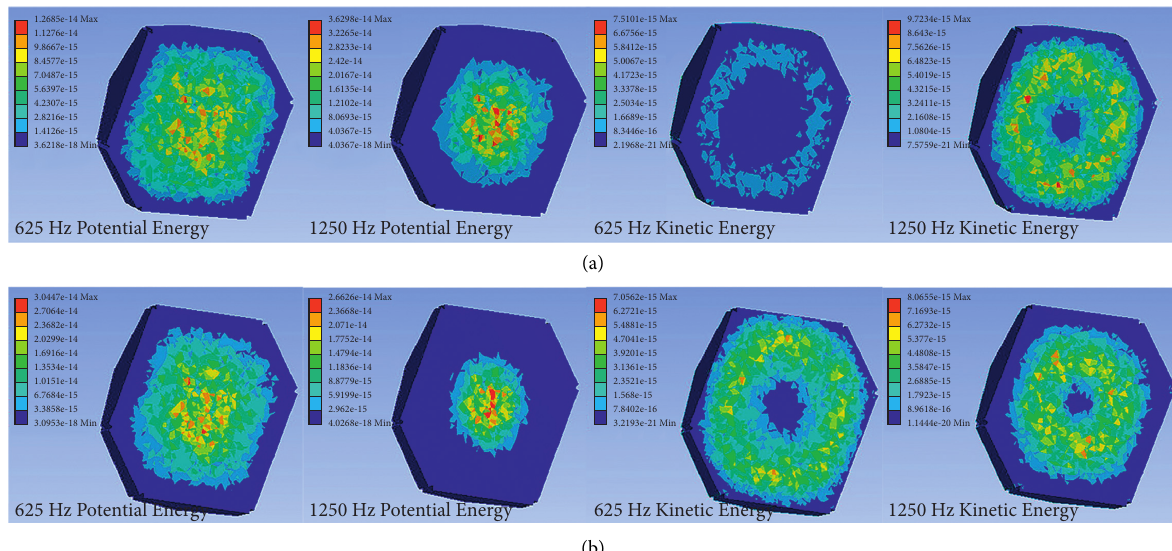
Figure 6: Acoustic potential energy and acoustic energy dissipation diagram at 625Hz and 1250Hz for (a) PU foam and (b) PU/Al